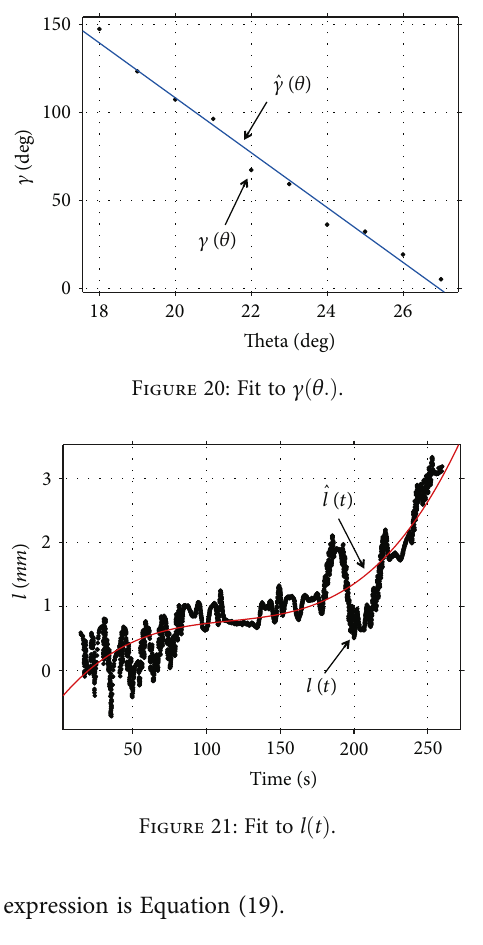
Figure 21: Fit to l ð t Þ